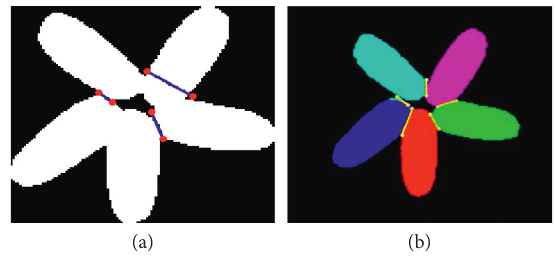
Figure 21: (a) The unimproved endpoint matching effect picture. (b) The improved endpoint matching effect picture.